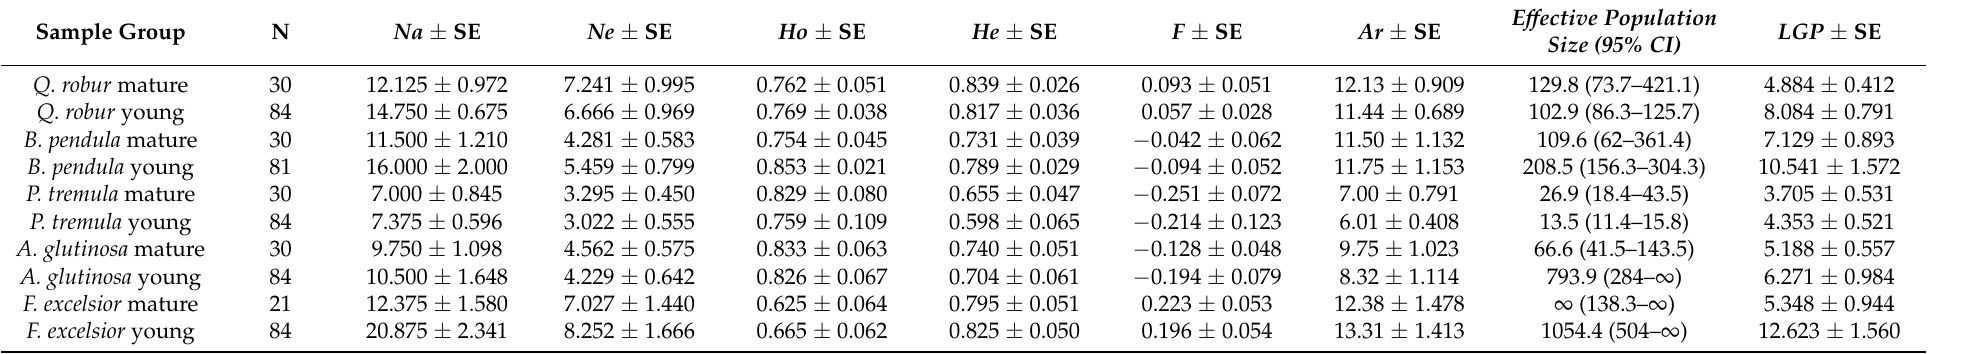
Table 3. Main parameters of genetic diversity, calculated for putatively maternal (mature) trees and self-regenerating juveniles (young) of common oak ( Quercus robur L.), silver birch ( Betula pendula Roth.), European aspen ( Populus tremula L.), black alder ( Alnus glutinosa (L.) Gaertn.), and European ash ( Fraxinus excelsior L.). N, sample size (number of sampled trees); Na , mean number of alleles; Ne, effective number of alleles; Ho , observed heterozygosity; He , expected heterozygosity; F , mean fixation index; Ar , allelic richness; CI, confidence interval; LGP , latent genetic potential; ± SE, standard